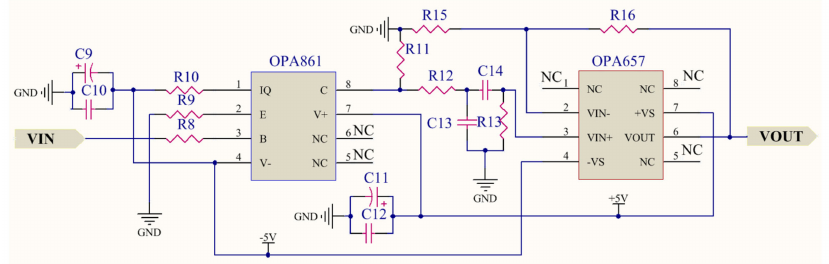
Figure 5. Schematic design of the signal amplifier and filter of a visible light communication (VLC) transmitter.